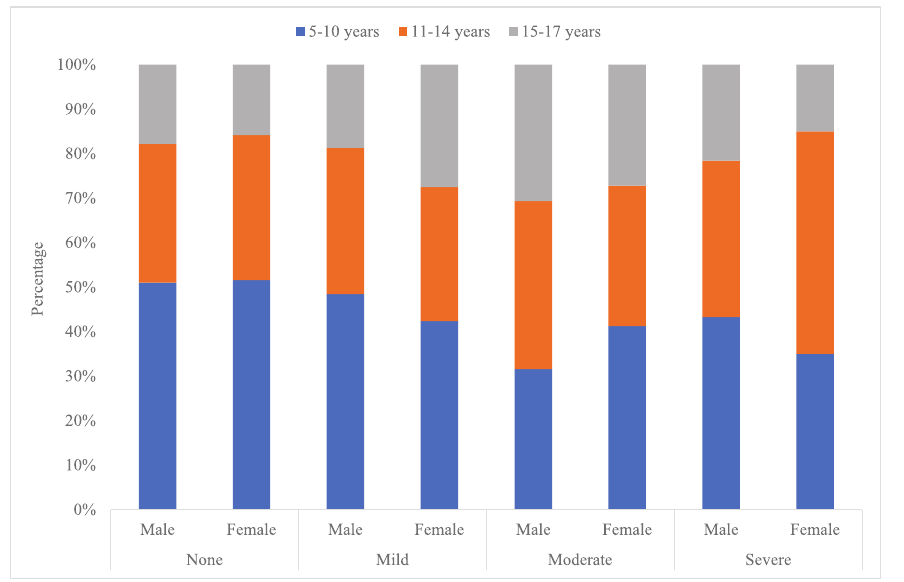
Fig 4. Percentage distribution of age category by disability category and sex of child (n = 1,439).